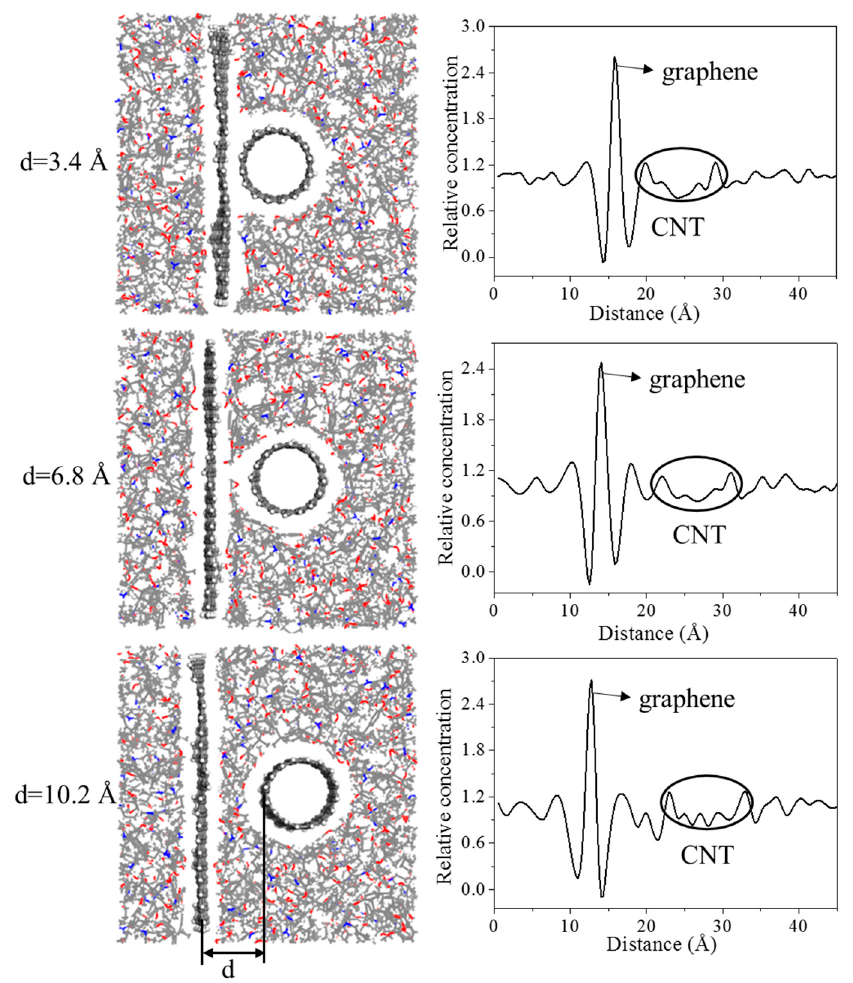
Figure 7. Equilibrium structures and relative concentrations of composite models with different distances between the CNT (8, 8) and graphene.